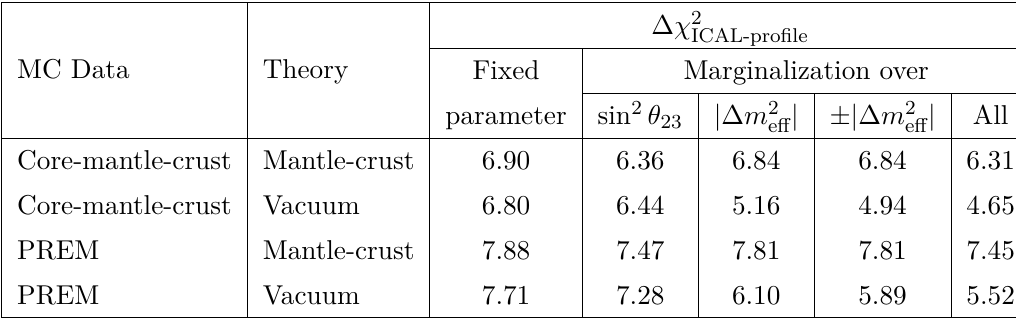
Table 7 . The impact of marginalization over oscillation parameters sin 2 θ 23 , | ∆ m 2 | , and mass eff ordering on the sensitivity of ICAL to rule out the alternative profile of Earth at the median ∆ χ 2 level. We assume true mass ordering as NO in data. The ∆ χ 2 for the fixed-parameter case ICAL-profile is given in the third column. The marginalized ∆ χ 2 obtained after performing minimiza- ICAL-profile tion separately over sin 2 θ , | ∆ m 2 (with both mass orderings) in theory are given | , and ∆ m 2 23 eff eff in fourth, fifth and sixth columns, respectively. The marginalized ∆ χ 2 after performing ICAL-profile combined minimization over sin 2 θ , ∆ m 2 , and both mass orderings in theory is given in the last 23 eff column. The remaining oscillation parameters are kept fixed at their benchmark values as men- tioned in table